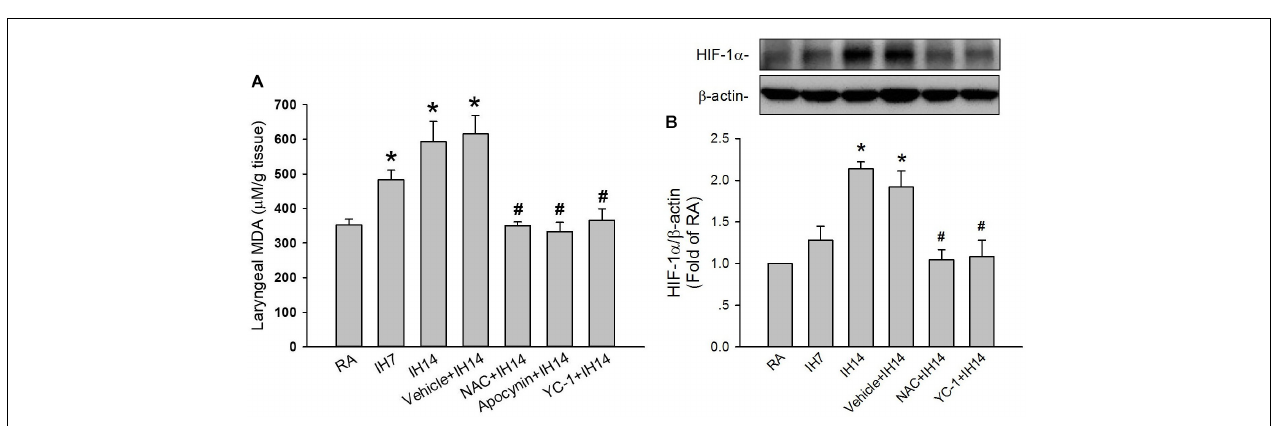
FIGURE 5 | Level of malondialdehyde (MDA) and protein expression of HIF-1 α in the laryngeal tissues of rats. (A) Three groups of rats were exposed to RA or intermittent hypoxia for 7 days (IH7) or 14 days (IH14), while the other four groups were exposed to IH14 with daily treatment with N-acetyl-L-cysteine (NAC + IH14), apocynin (apocynin + IH14), YC-1 (YC-1 + IH14) or their vehicle (Vehicle + IH14). The laryngeal levels of MDA, an indicator of oxidative stress, in seven groups were analyzed by an assay kit. (B) Three groups of rats were exposed to RA or IH for 7 days or 14 days, while the other three were exposed to IH14 with daily treatment with NAC (NAC + IH14), YC-1 (YC-1 + IH14) or their vehicle (Vehicle + IH14). The protein levels of HIF-1 α in the laryngeal tissues were analyzed through Western blot analysis to assess HIF-1 activation. Data in each group are means ± SE of five rats. * p < 0.05 compared with RA; # p < 0.05 compared with Vehicle +